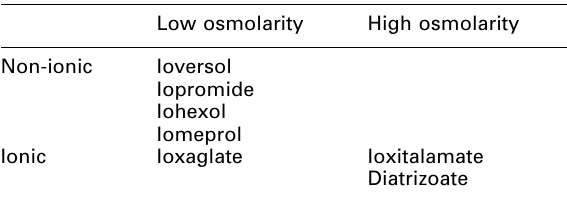
Table 1. Classification of